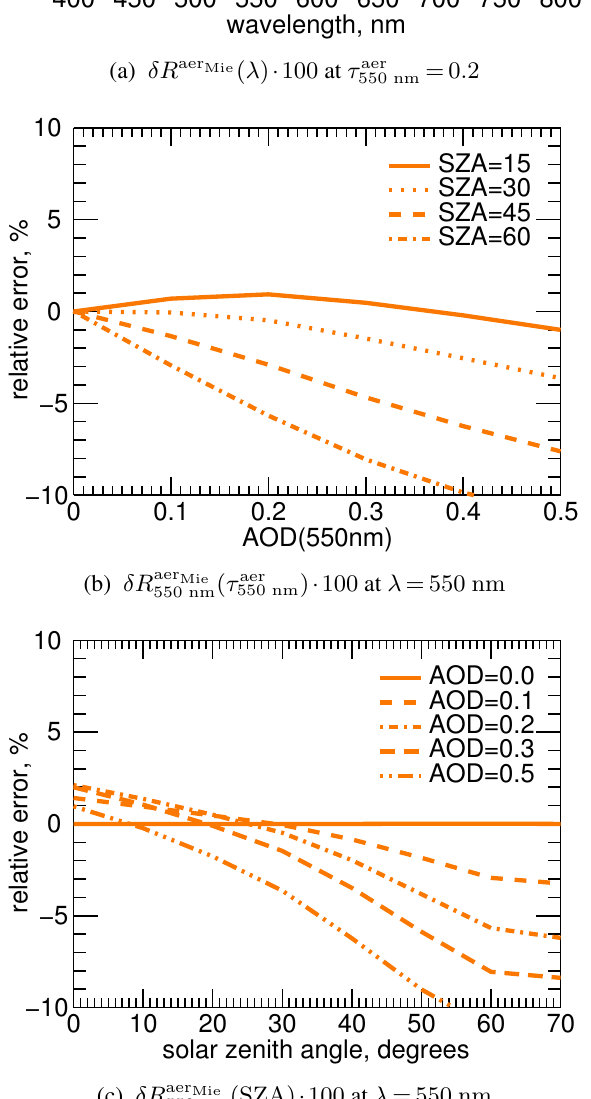
Fig. 3: Percent error of the SMART reflectance function due Fig. 3. Percent error of the SMART reflectance function due to to aerosol scattering with respect to wavelength, aerosol op- aerosol scattering with respect to wavelength, aerosol optical depth tical depth (AOD) and solar zenith angle (SZA) at top-of- (AOD) and solar zenith angle (SZA) at top-of-atmosphere. SMART and 6S use the same phase function from Lorenz-Mie theory. atmosphere. SMART and 6S use the same phase function from Lorenz-Mie theory.